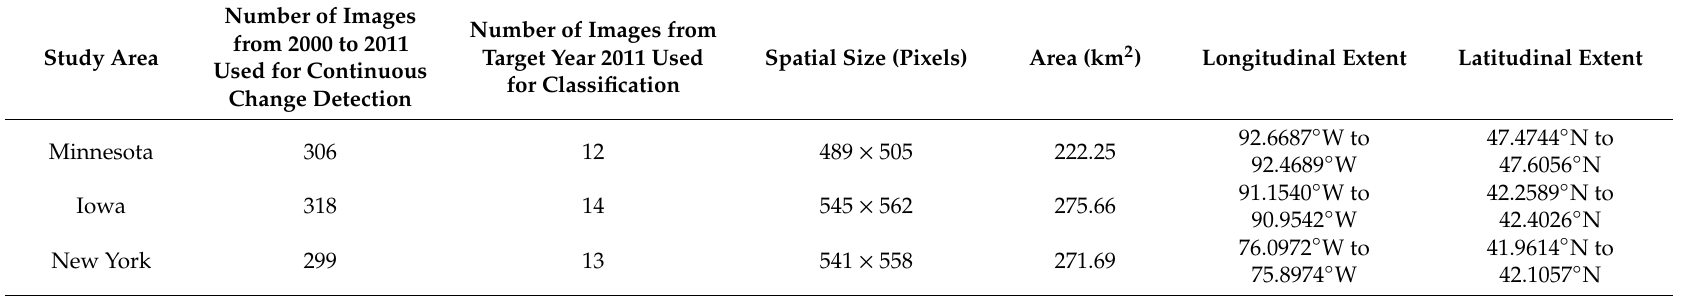
Table 1. Summaries of the number of images from 2000 to 2011 used for continuous change detection, the number of images from the target year 2011 used for classification, and the geographic characteristics of the three study